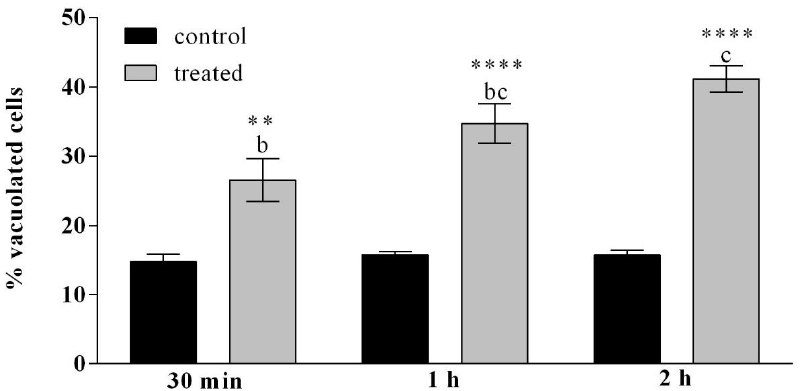
Figure 3. Percentage of haemocytes showing vacuolization, after treatment with OPs deriving from 2 equivalent females at different incubation times (30 min, 1 h and 2 h) and observed after May Grunwald–Giemsa (MGG) staining. Data are presented as means ± SD ( n = 3 replicates). Statistical analysis was performed with one-way ANOVA and Bonferroni (for control vs. treatment analysis) and Tukey post-hoc test (for all sample analysis). Different letters indicate significant differences among all treatments ( p value < 0.0001), asterisks indicate significant differences between control and treated samples at the same experimental time (** p value < 0.01; **** p value < 0.0001).